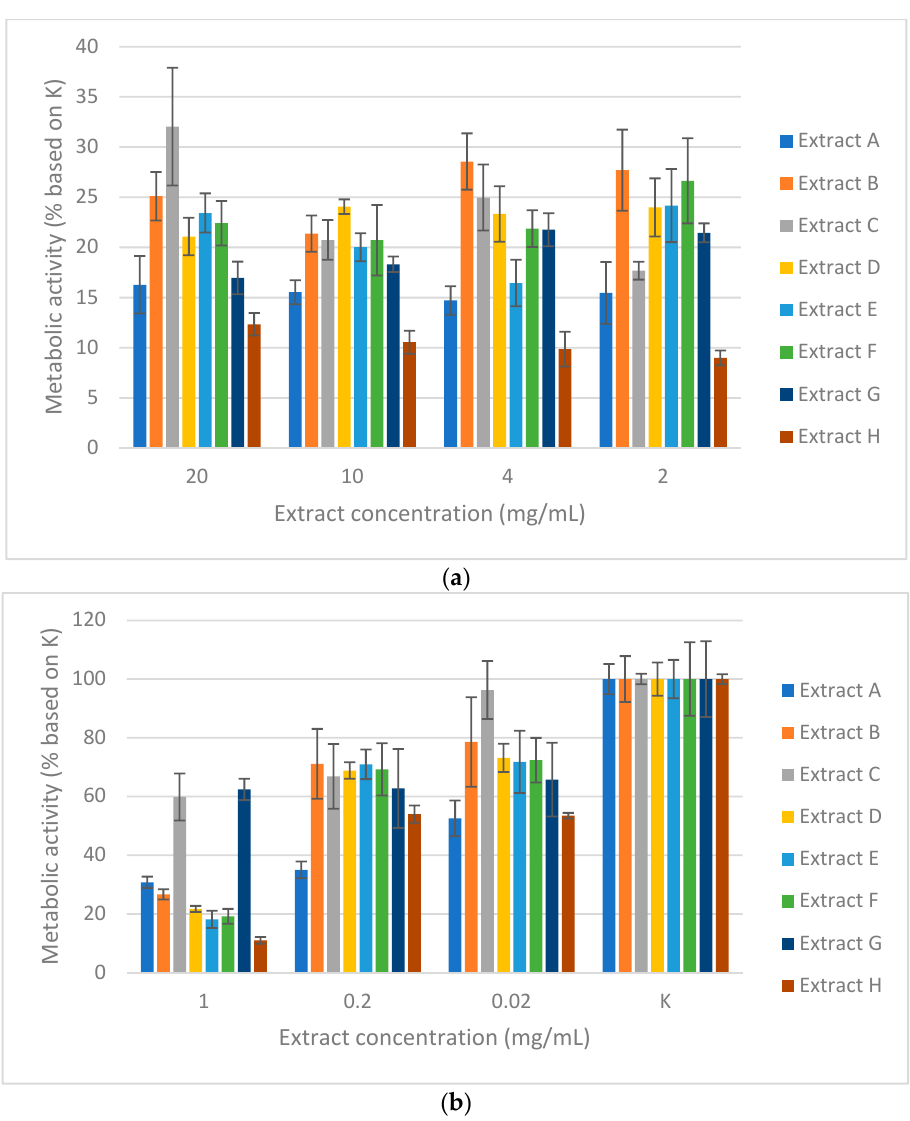
Figure 4. ( a ). Inhibitory effects of all 8 used extracts with higher concentrations on WM-266-4 human melanoma cells. ( b ). Inhibitory effects of all 8 used extracts with lower concentrations and control on WM-266-4 human melanoma cells.